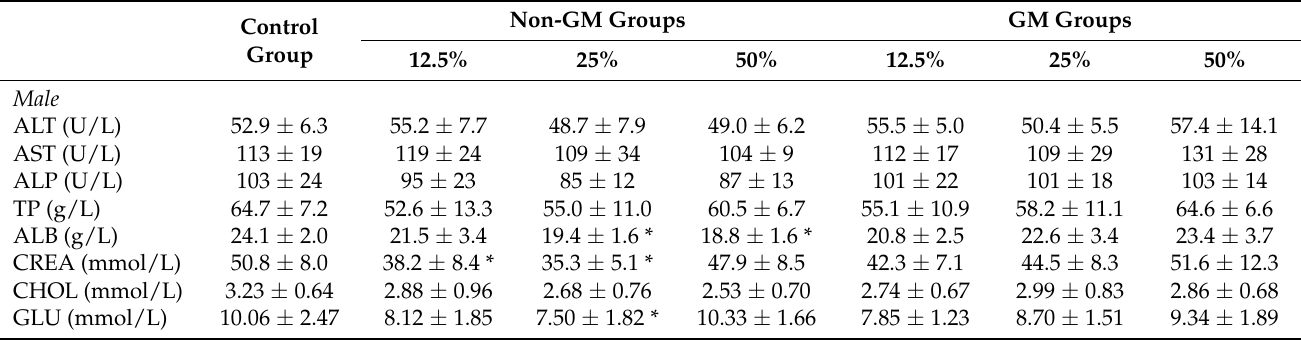
Table 8. Serum chemistry of male and female rats feed with different diets ( n =